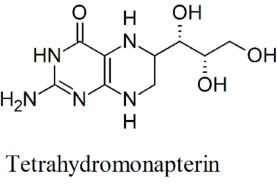
Figure 6. Chemical formula of